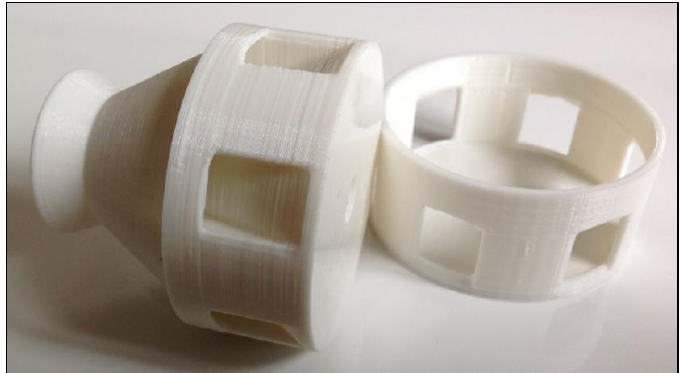
Figure 9. A nozzle block prototype (shown on the left) and a control sleeve (diaphragm)